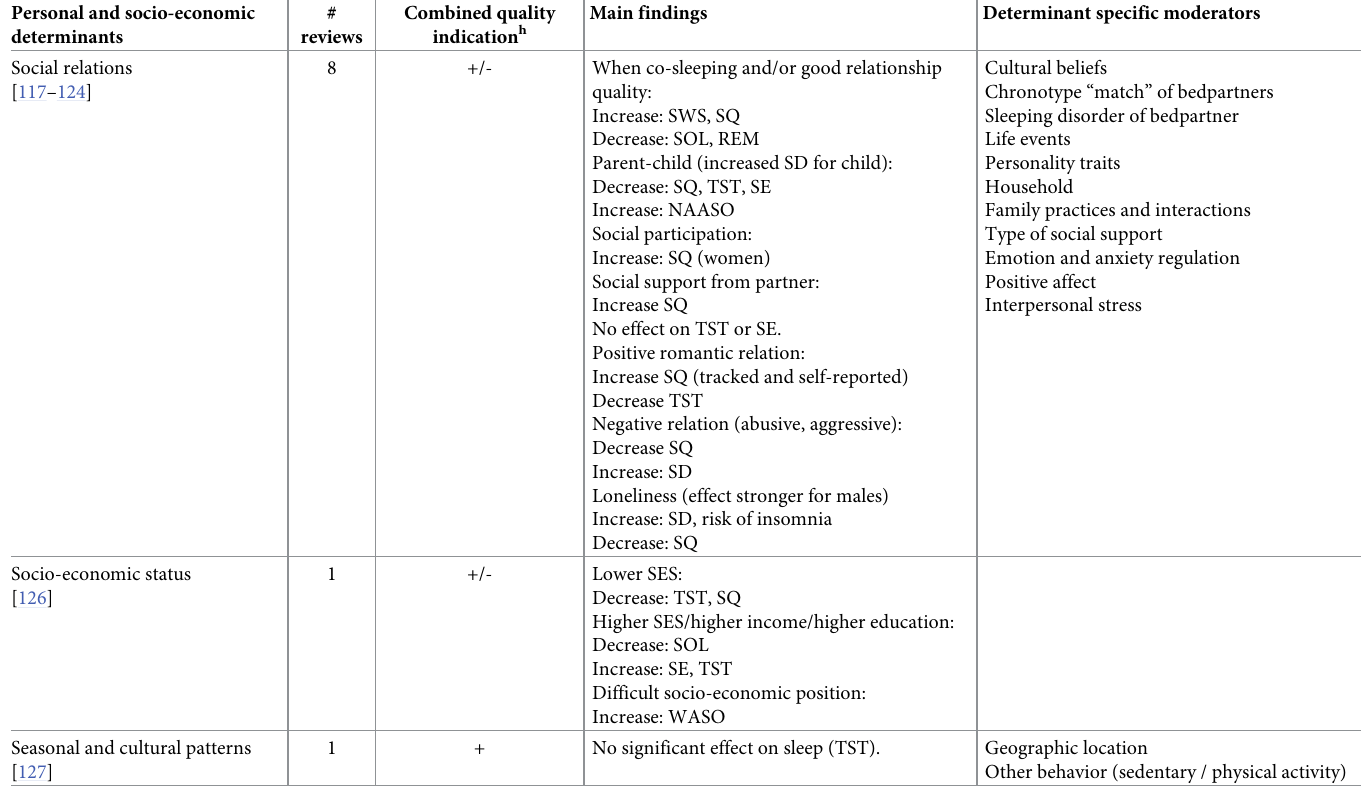
Table 3 provides an overview of all identified biological determinants of